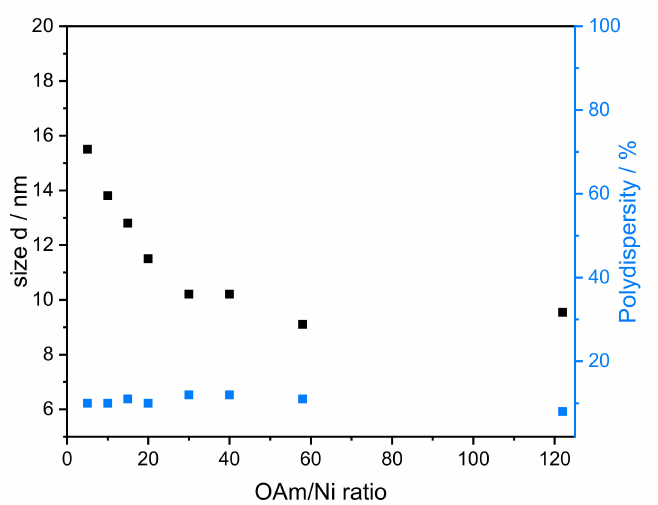
Figure 4. Nanoparticle size relative to OAm / Ni ratio with corresponding polydispersity, based on SAXS data. T = 220 ◦ C, t = 2 h, [Ni] = 50 mmol / L, TOP / Ni = 1.5.